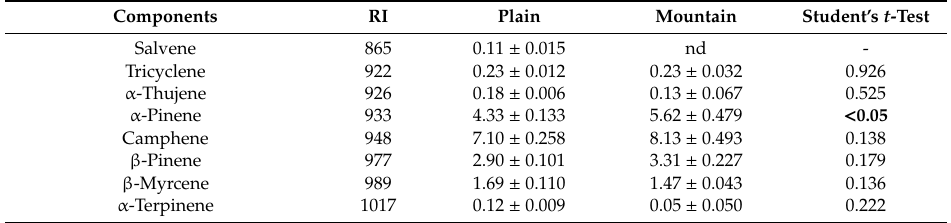
Table 9. Chemical composition (%) of essential oils of sage plants grown at di ff erent altitudes (plain vs. mountain). Data are expressed as means ± SE (n = 3), and significant di ff erences ( p < 0.05, p < 0.01, p < 0.001) in bold between treatments are indicated by Student’s t -test p